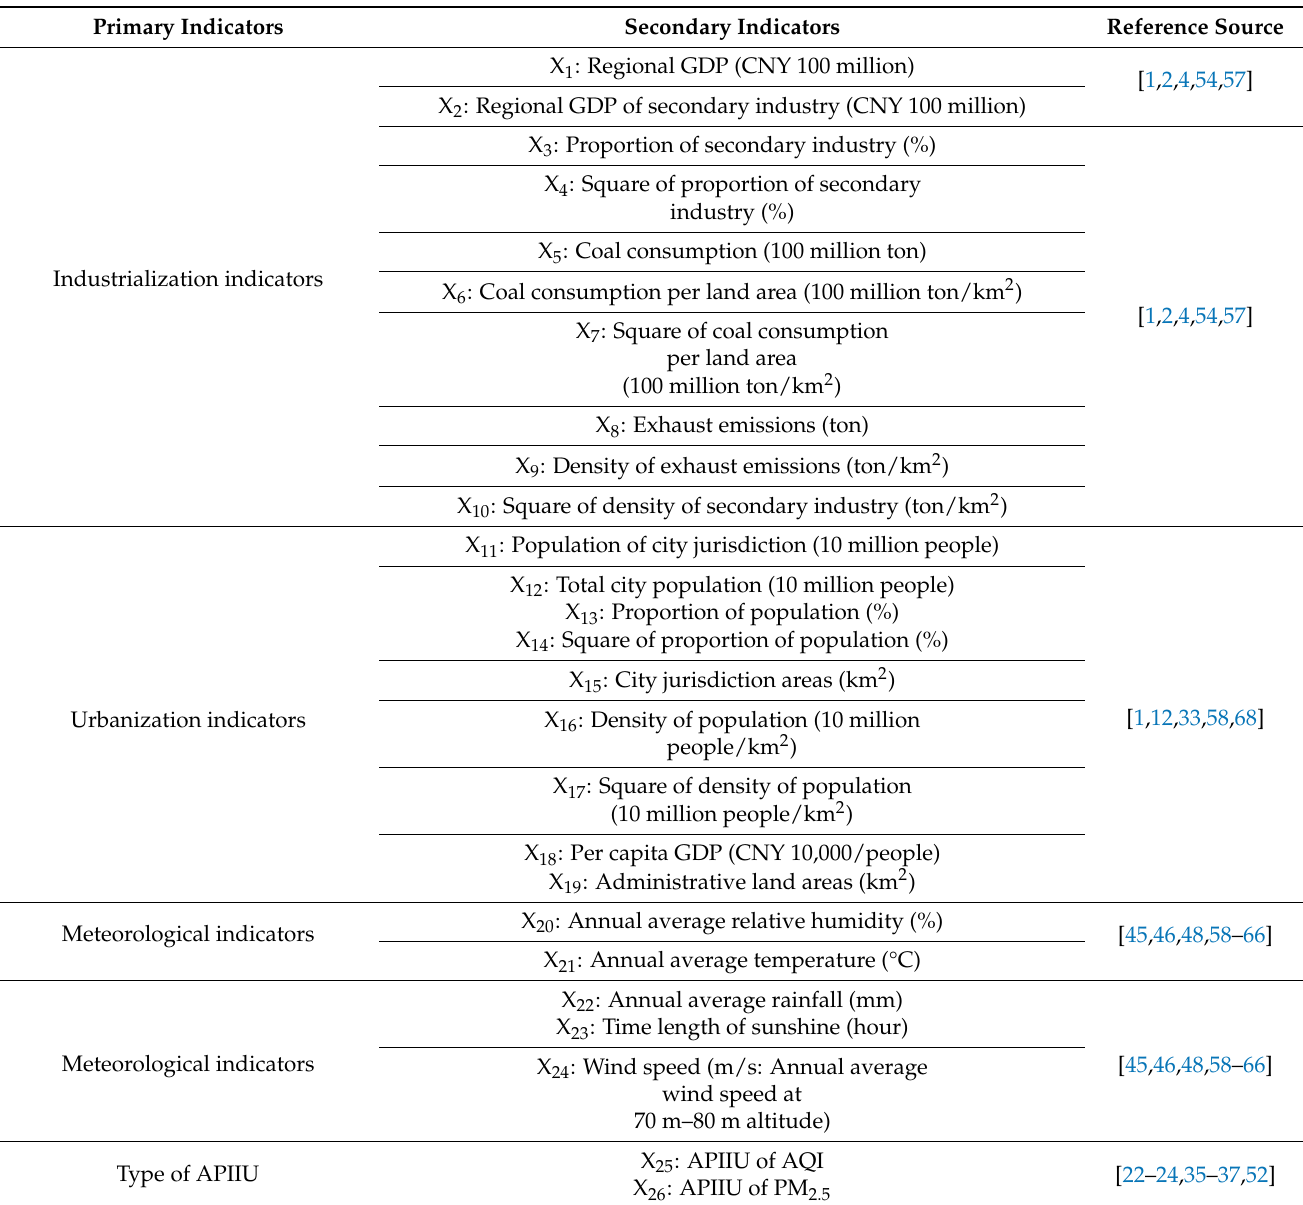
Table 1. Primary and secondary